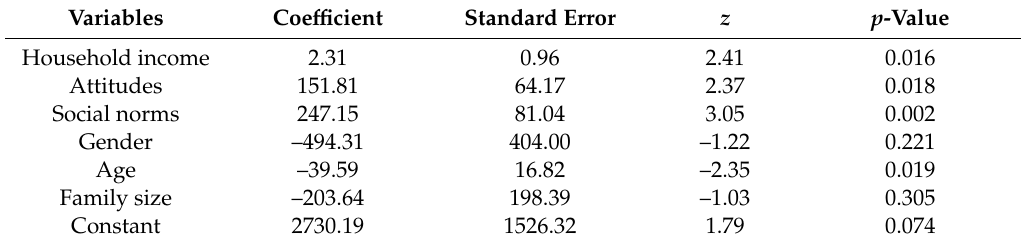
Table 5. Estimated parameters of the double-bounded choice model for IAA rice.